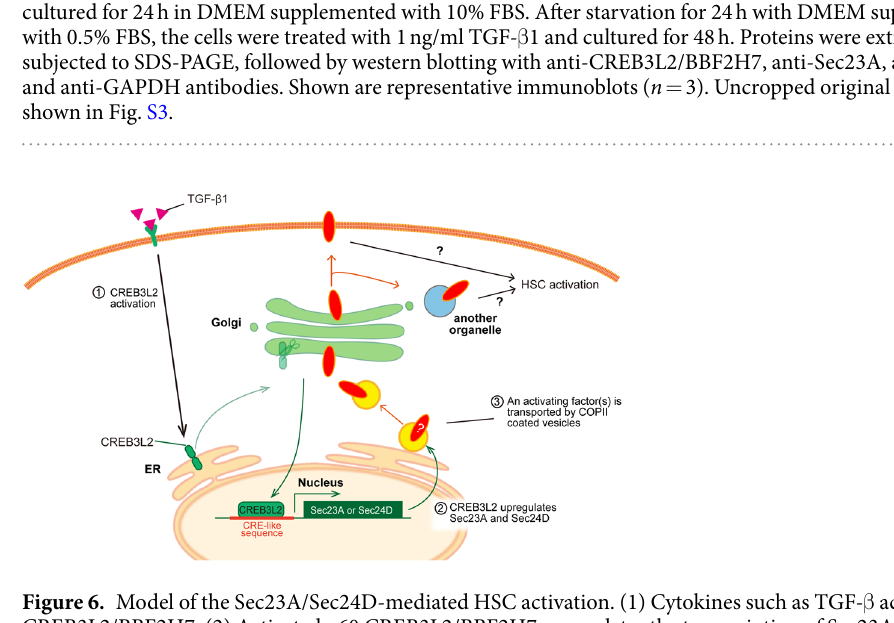
Figure 6. Model of the Sec23A/Sec24D-mediated HSC activation. (1) Cytokines such as TGF- β activate CREB3L2/BBF2H7. (2) Activated p60 CREB3L2/BBF2H7 upregulates the transcription of Sec23A and Sec24D. (3) An activated factor(s) is transported by a COPII-dependent process for HSC